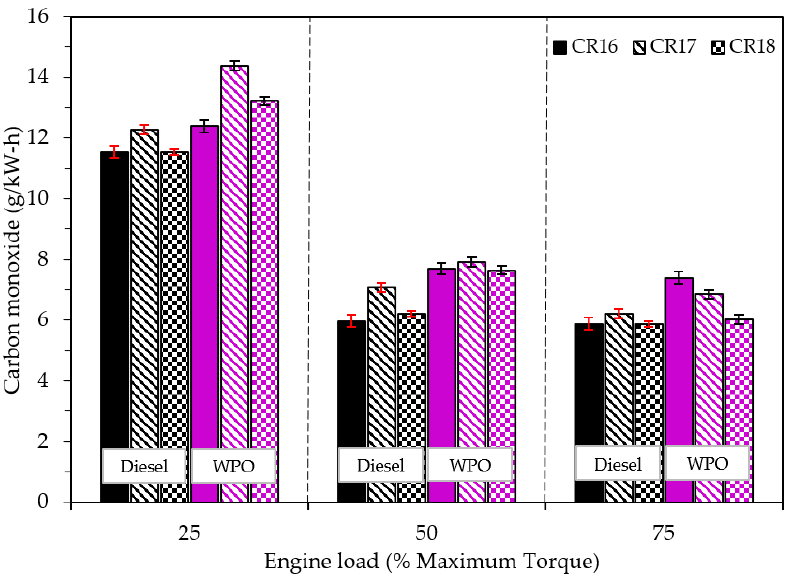
Figure 9. Variation in the carbon monoxide (CO) emissions with engine loads.